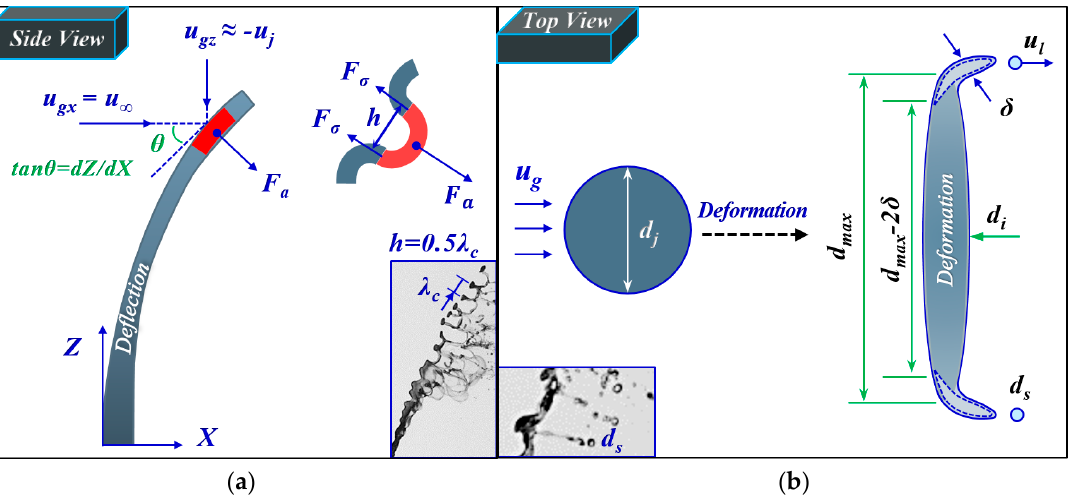
Figure 10. Phenomenological analyses of the liquid breakup at a small We g : ( a ) Column breakup caused by aerodynamic instability; ( b ) Surface breakup caused by boundary-layer stripping.